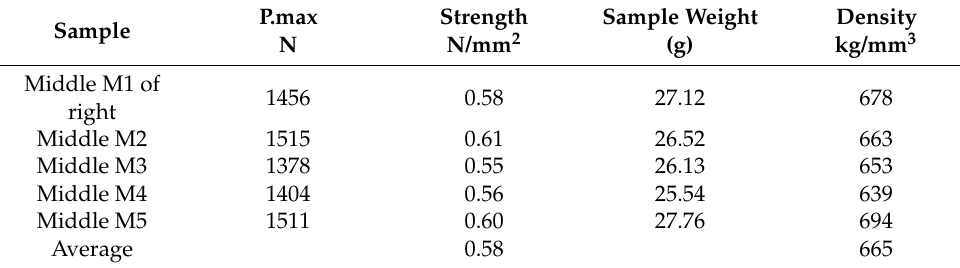
Table 18. Internal bonding test results.